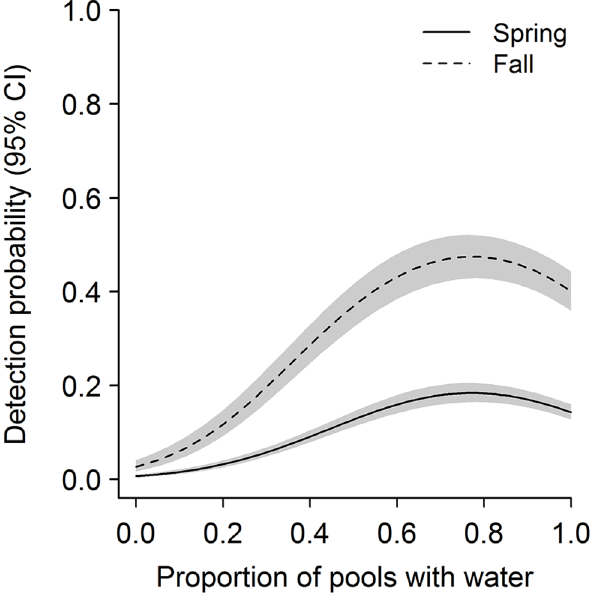
Fig 2. Detection probabilities of adult lowland leopard frogs as a function of survey-specific water availability between 1996 and 2011 in the Rincon Mountains, Arizona, USA. Shaded areas represent 95% confidence intervals. We made predictions from a model of detection probability as a function of effort, survey-specific water availability, and date (Table 2). We predicted detection probability for the midpoint of spring and fall sampling periods (approximately 7 June and 31 Oct) when observers surveyed pool complexes in their entirety (i.e., effort = 1).